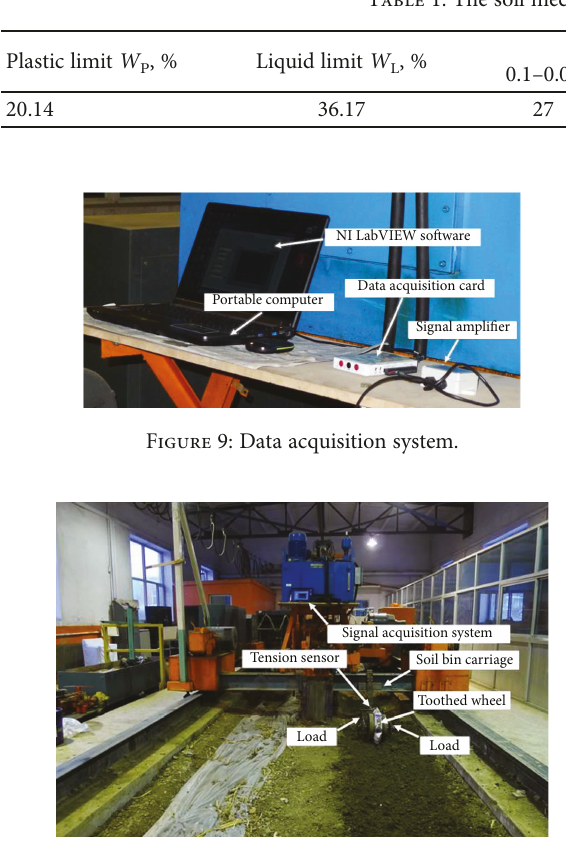
Figure 10: Forward resistance test platform for the toothed